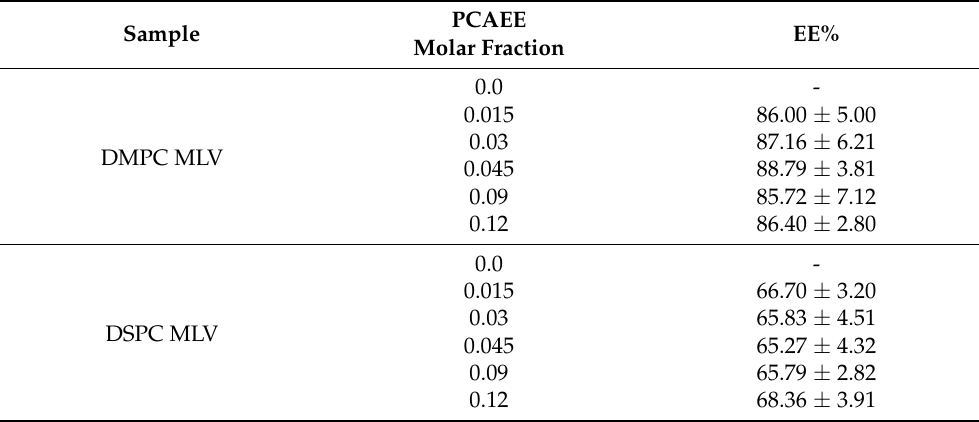
Table 1. PCAEE encapsulation efficiency (EE) of DMPC MLV and DSPC MLV.